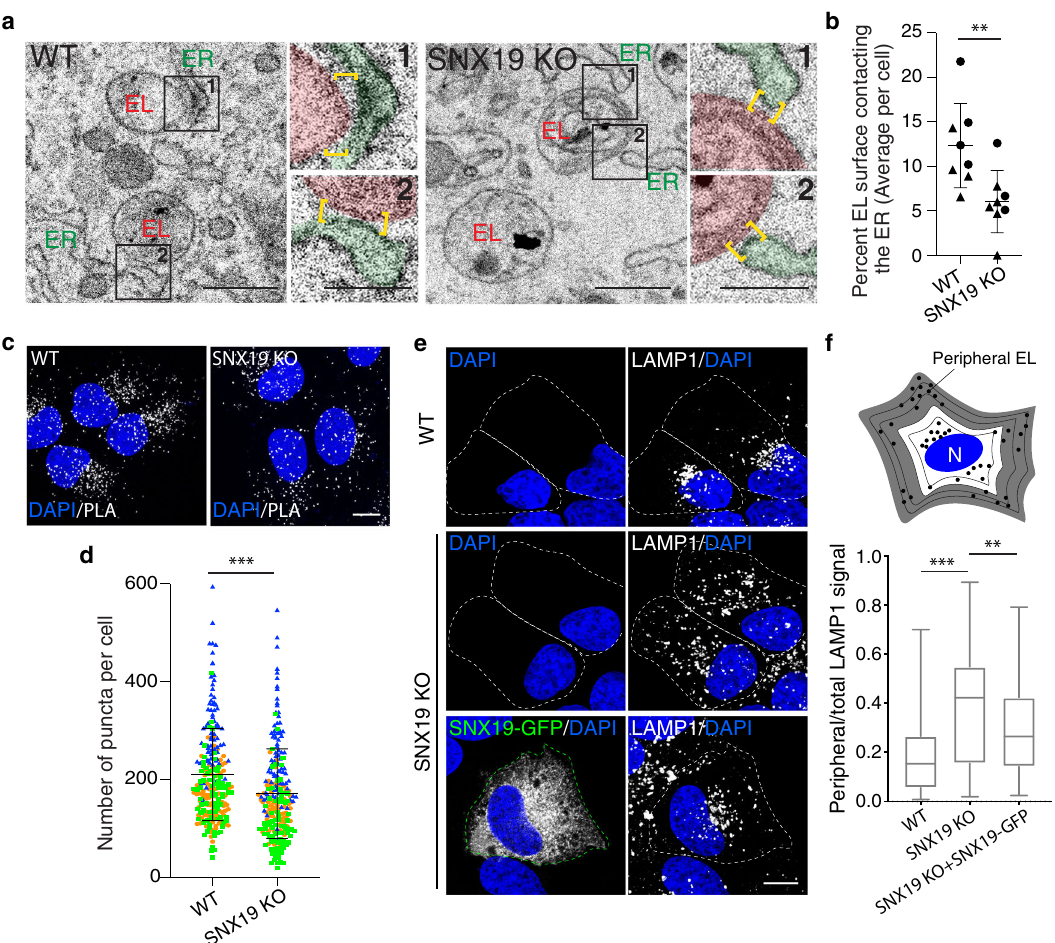
Fig. 5 Loss of SNX19 reduces overall ER – EL contacts and causes EL dispersal. a WT or SNX19-KO U-2 OS cells were allowed to endocytose BSA-gold for 24 h to label ELs. Cells were then fi xed, embedded in plastic, and subjected to serial sectioning (50-nm sections). Images show single EM sections with representative ELs. Insets are close-up images of ER – EL contacts, where ELs are shaded in red, the ER is shaded in green and yellow brackets de fi ne the ER – EL contact sites. b Quanti fi cation of data in a . For each section that captured a gold-containing EL, the perimeter of the EL membrane was measured. The same was done for the portion of the EL membrane that was closely apposed to an ER membrane (i.e., contact length). All EL perimeters and contact lengths across the sections that captured a given EL were summed up, the total contact lengths were divided by the total EL perimeter lengths and multiplied by 100 to compute the percentage of the EL perimeter that contacts the ER. Contacts were quanti fi ed in multiple sections from n = 8 cells per condition across two independent experiments. Graph shows a line at the mean and SD. Unpaired t -test was performed, ** two-tailed p -value = 0.009. c WT or SNX19-KO U-2 OS cells were fi xed, immunostained with rabbit anti-LAMP1 and mouse anti-calnexin antibodies. A proximity ligation assay (PLA) was then performed using anti-mouse and anti-rabbit probes, and detected in the 647-nm channel. The PLA signal is shown in white in two representative confocal micrographs. d Quanti fi cation of PLA puncta from c . A threshold was applied to eliminate background signal and the total number of puncta per cell was computed in three experiments, each consisting of 60 – 80 cells per condition. Graph shows a line at the mean and SD. Unpaired t -test was performed, *** two-tailed p -value < 0.001. e WT or SNX19-KO U-2 OS cells were fi xed, immunostained with anti-LAMP1 antibody, and imaged by confocal microscopy. Bottom row shows a SNX19-KO cell that was transfected with a SNX19-GFP construct. f Quanti fi cation of peripheral ELs from experiments such as that shown in e . Cell outlines were traced and the outline was iteratively shrunken by 2 μ m to generate 5 “ shells ” per cell. The scheme on top depicts combinations of the 3 outermost shells in gray, and 2 innermost shells in white. LAMP1 signal in the gray region (peripheral ELs) was quanti fi ed and divided by LAMP1 signal in combined gray and white regions (total ELs). Box and whisker plot represents data from 3 independent experiments where 7 – 20 cells were analyzed per condition in each experiment. The box extends from 25th to 75th percentiles, the horizontal line represents the median, and the whiskers represent the minimum and maximum values. Statistical signi fi cance was calculated with the Mann – Whitney test; *** two-tailed p- value < 0.001, ** two-tailed p -value = 0.0081. Source data are provided as a Source Data fi le. Scale bars: 500 nm in a , 250 nm insets and 10 μ m in c and e